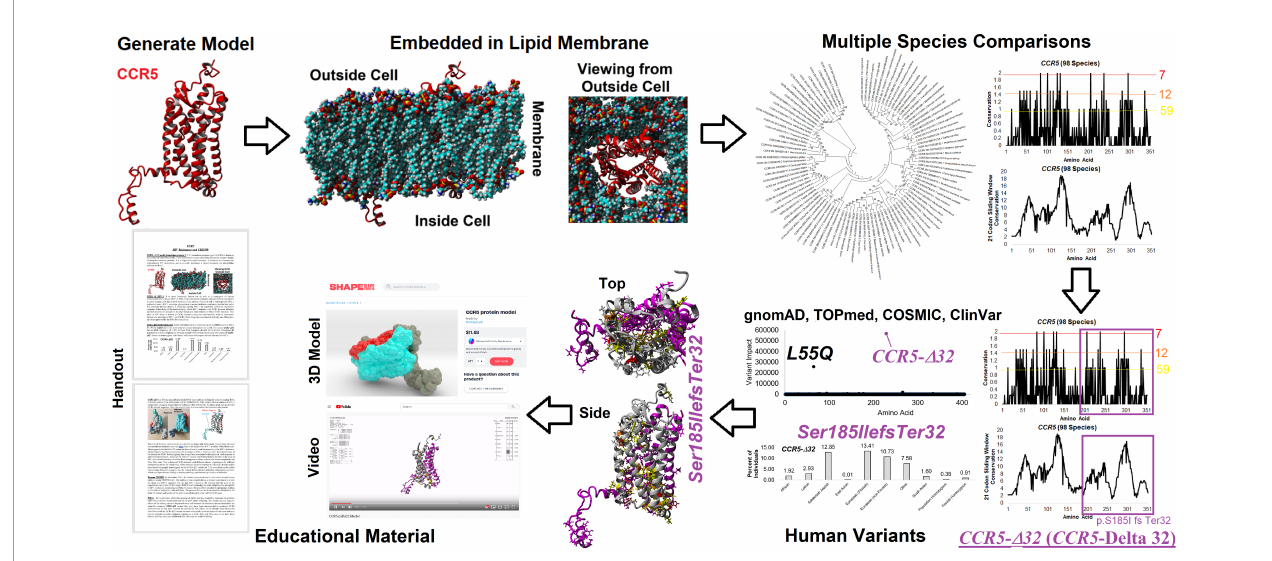
FIGURE 2 | Amino acid knowledgebase of CCR5 used for educational insights. CODE students generated protein models, which were embedded into a lipid membrane and run for molecular dynamics simulations. These values were combined with multiple species analysis of CCR5 evolution and genomic variant extractions from gnomAD, TOPmed, COSMIC, and ClinVar. This amino acid knowledgebase was then used to assess the delta 32 variant and generate various educational handouts, videos, and 3D printed